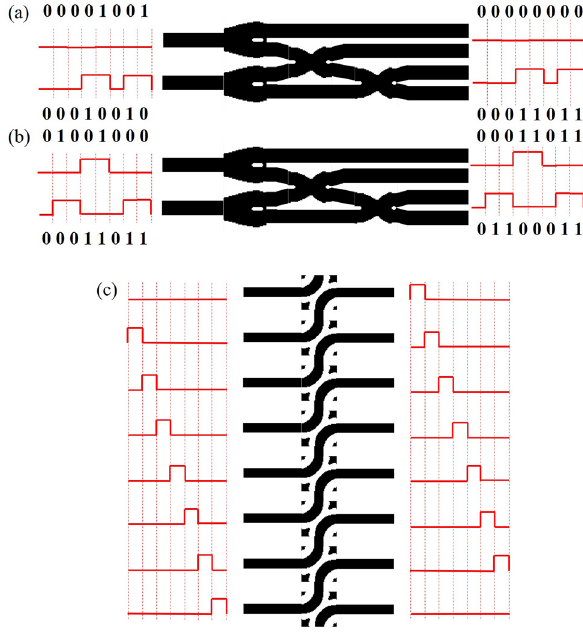
Figure3: Thebasicworkingprincipleoftheall-opticalcalculationpart. (a) The “ 00001001 + 00010010 ” input state of signal light in the form of light pulse. (b) The “ 01001000 + 00011011 ” input state of signal light in the form of light pulse. (c) The results of shifter when signal lights are input into each waveguide in turn.